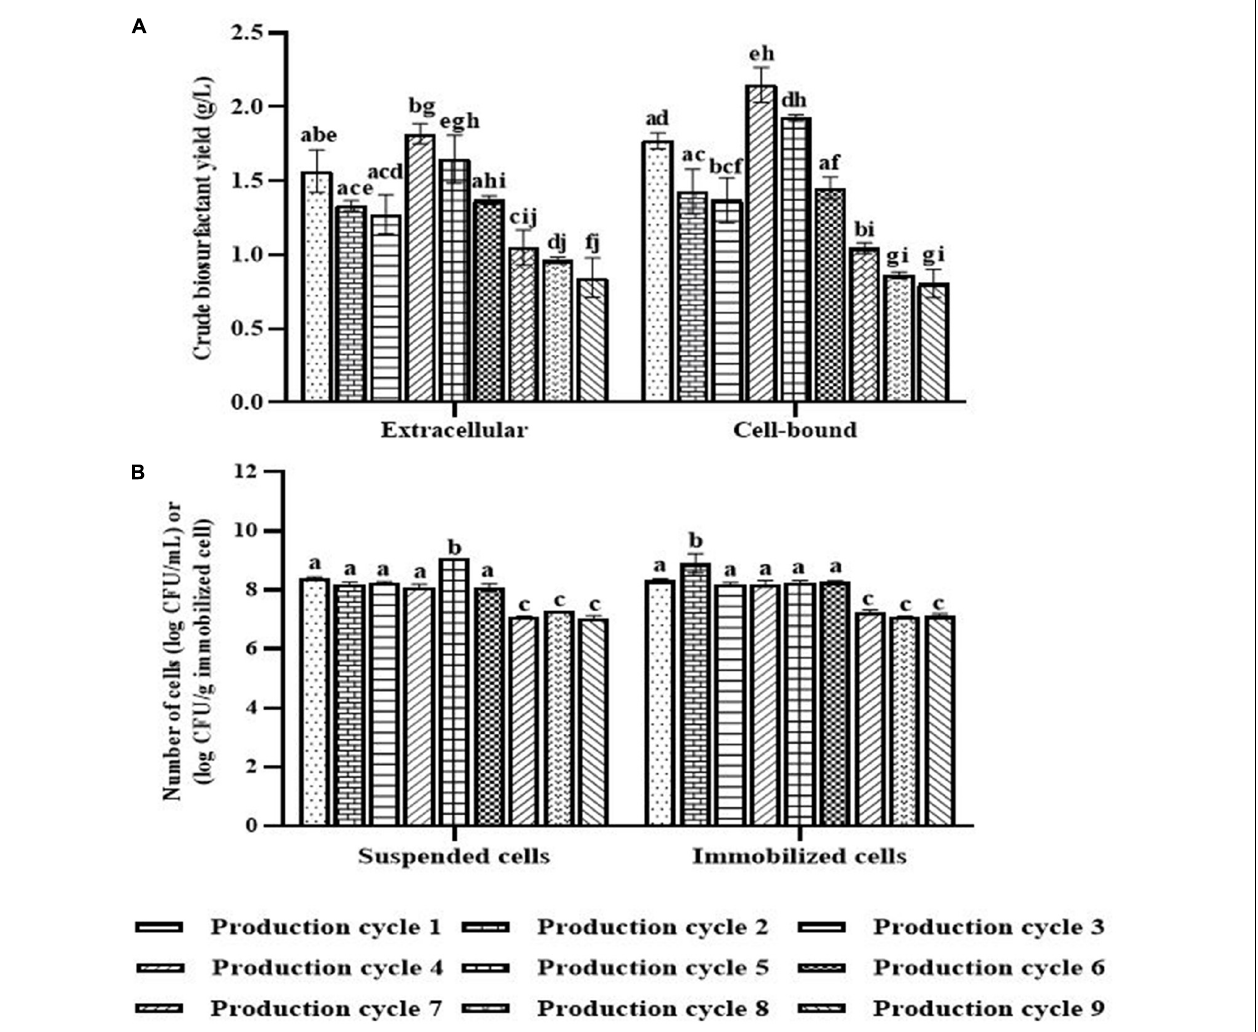
FIGURE 4 | Crude biosurfactant yields (A) and bacterial cell numbers (B) after each production cycle with washing and reactivation processes. The immobilized cells were washed with PBS at pH 8.0 before reused in the next cycle. Before the 4th and 7th production, the washed immobilized bacteria were reactivated with Luria-Bertani (LB) for 48 h. The biosurfactant yield was based on volume of production medium. The yields of extracellular/cell-bound biosurfactants were compared between production cycles. Error bars represent mean ± standard deviation ( n = 3). Two-way ANOVA: Tukey’s Multiple Comparison Test was used for statically analysis. Different letters represent the significant value ( P <